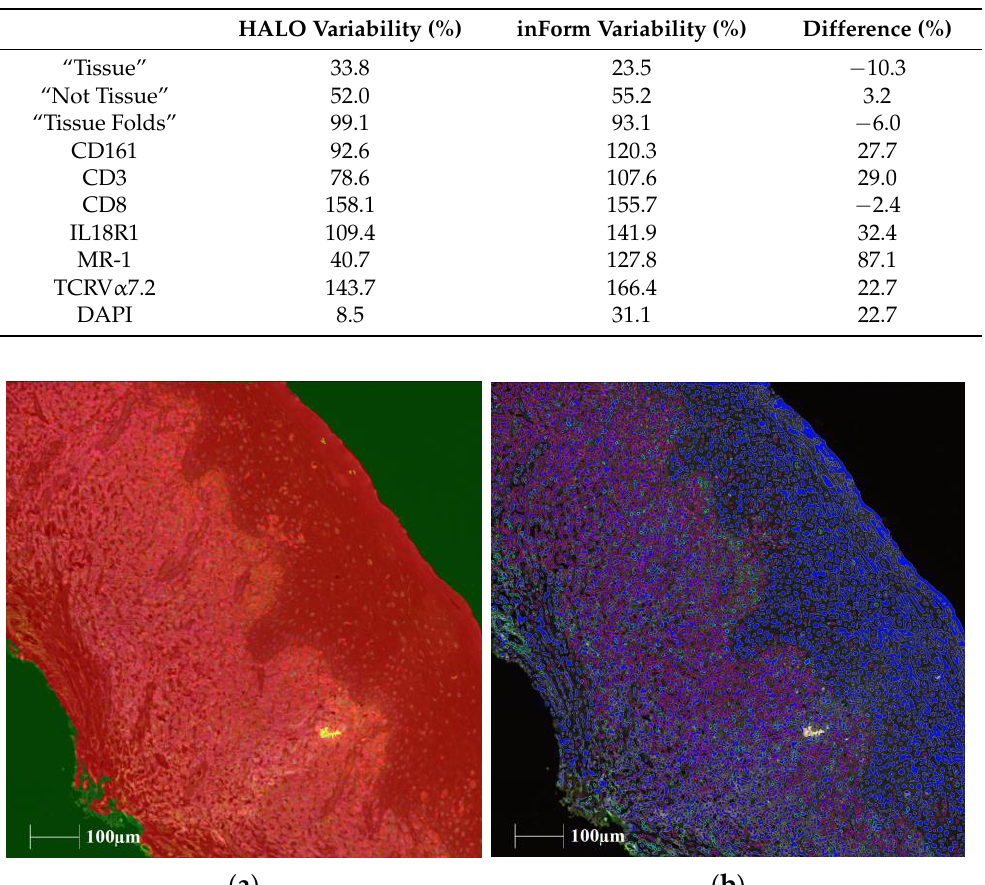
Table 1. Percentage variability between tissue segmentation and single antibody analysis for HALO ™ and inForm using raw data.